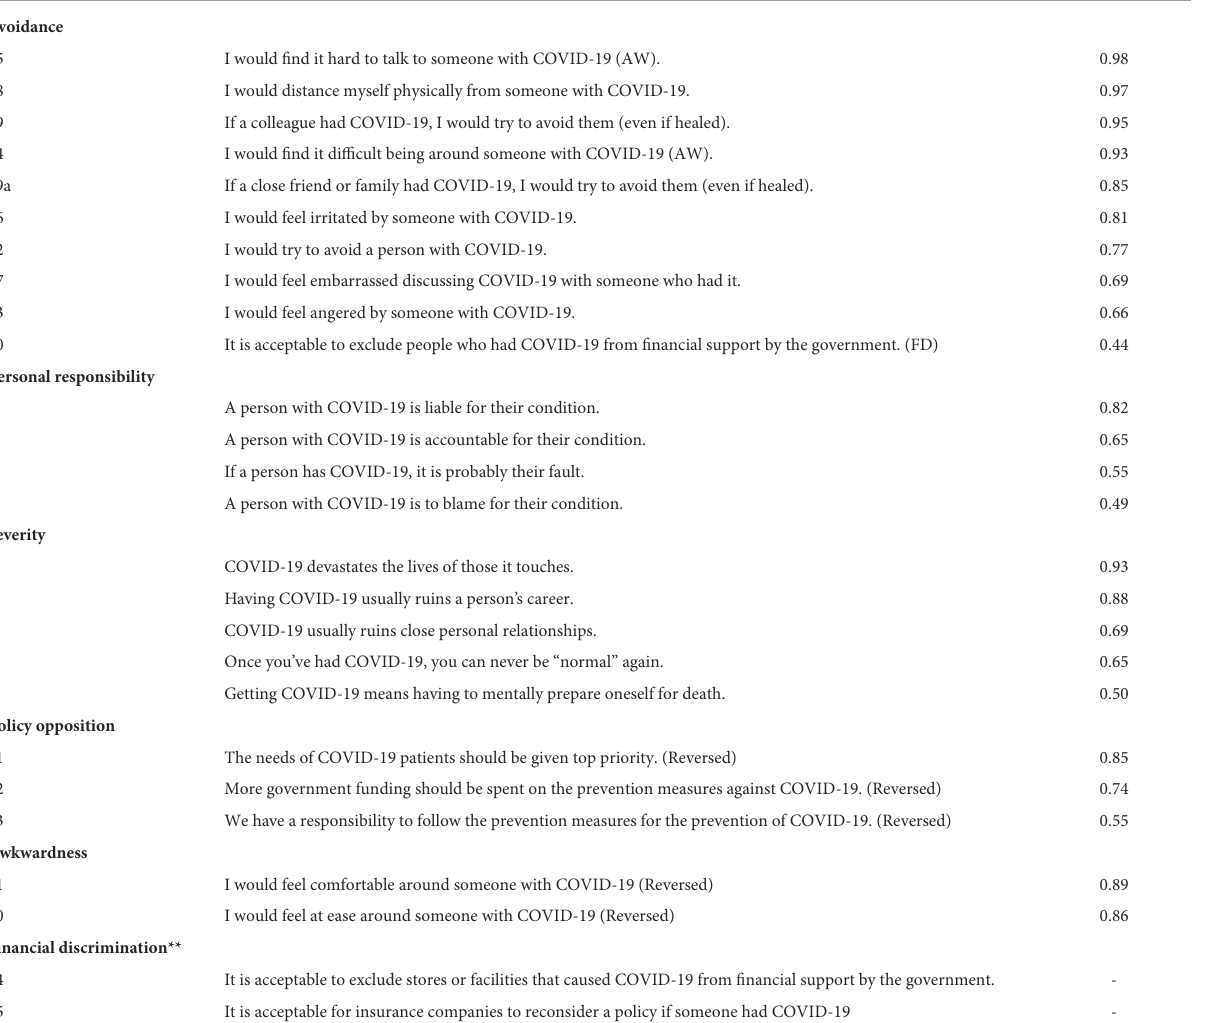
TABLE 2 Explanatory factor analysis of COVID-19 stigma